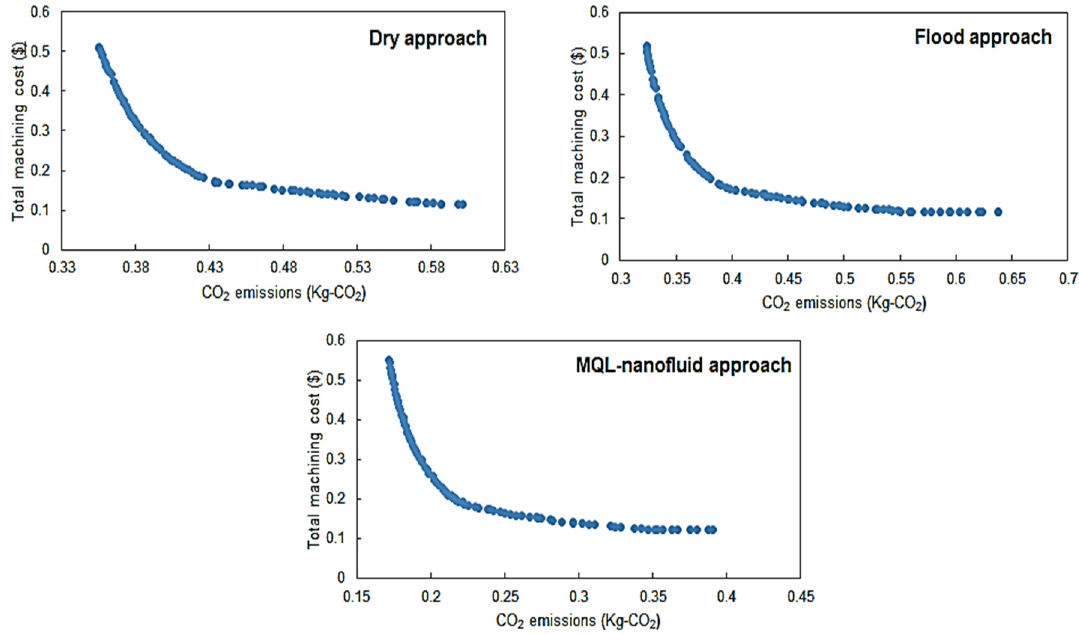
Figure 9. Pareto fronts for Model II for dry, flood and MQL-nanofluid strategies.